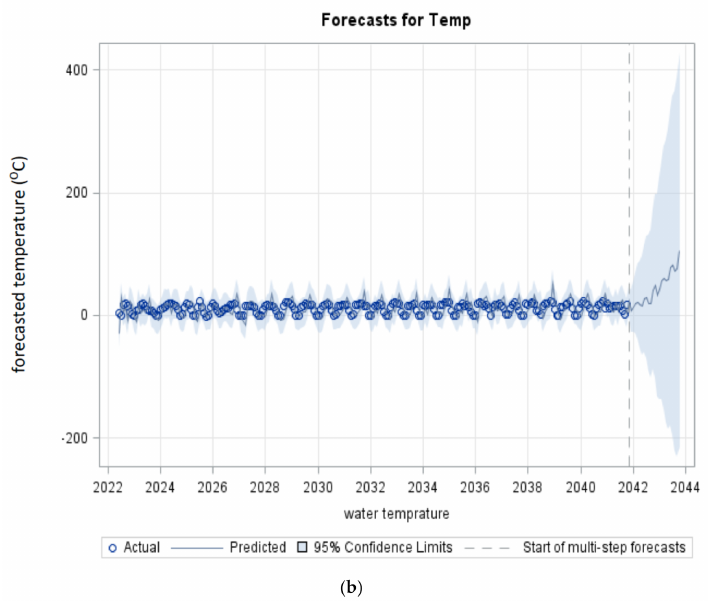
Figure 13. ARIMA analysis for the water temperature forecast over time at a different location than the sediment energy location (Eteläinen Kaupunkiselkä 1) near the city of Vaasa. In the figure – 200 = minus 200. ( a ) shows forecast in water temperature 2041 up to 2043. ( b ) shows forecast in water temperature from 2022 to 2044.